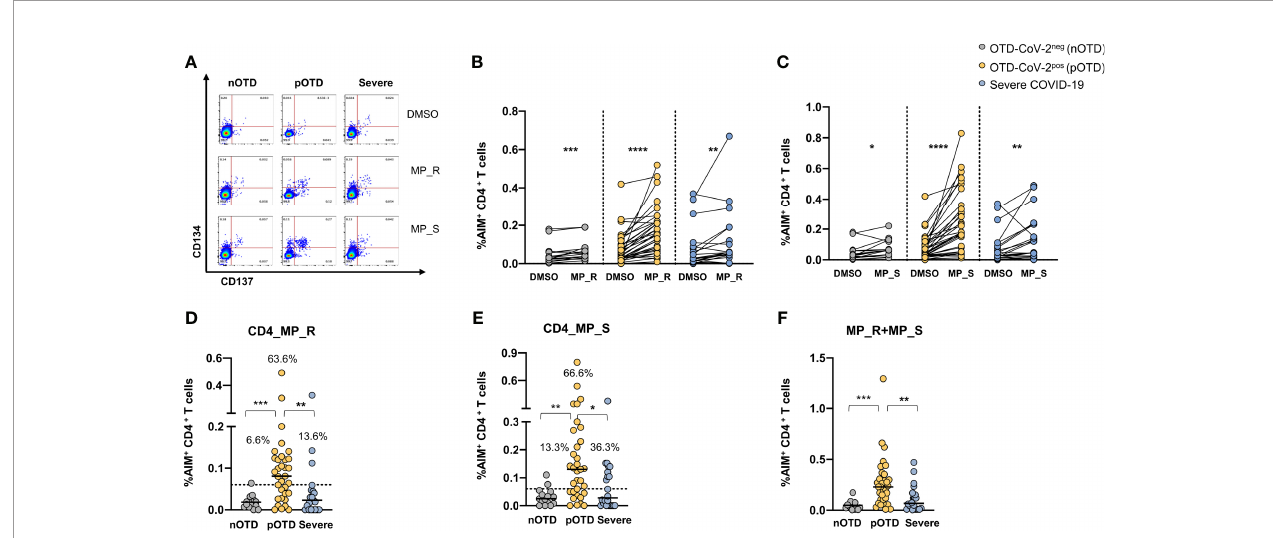
FIGURE 1 | Increased SARS-CoV-2 speci fi c CD4 T cell responses in SARS-CoV-2-infected subjects with OTD. Antigen-speci fi c activation of CD4 + T cells was evaluated in PBMC collected from all patients following 24h stimulation with the peptide megapool obtained from the amino acid sequence of the Spike glycoprotein (MP_S), or from the remainder of the SARS-CoV-2 orfeome (MP_R). DMSO was used as a negative control. (A) FACS plot examples of CD134 and CD137 co- expression on total CD4 + T cells. (B) Frequency of AIM+ (CD134 + CD137 + ) CD4 + T cells obtained by stimulation with MP_S, (C) MP_R or DMSO negative control is shown for the 3 different groups. (D) Activation of SARS-CoV-2 speci fi c CD4 + T cells, in the presence of MP_S and (E) MP_R megapools, is shown as percentage AIM + CD4 + T cells after subtraction of the vehicle background in the three cohorts. Dotted black lines indicate cut-off values for positivity. (F) Combined AIM + CD4 + T cells responses to DMSO-subtracted individual peptide megapools. The non-parametric Wilcoxon matched-pairs signed-rank test was used to compare data within the same group. Statistical comparison between three groups of subjects was assessed by the non-parametric Kruskal-Wallis test followed by Dunn ’ s multiple comparisons. *p < 0.05; **p < 0.01; ***p < 0.001; ****p <